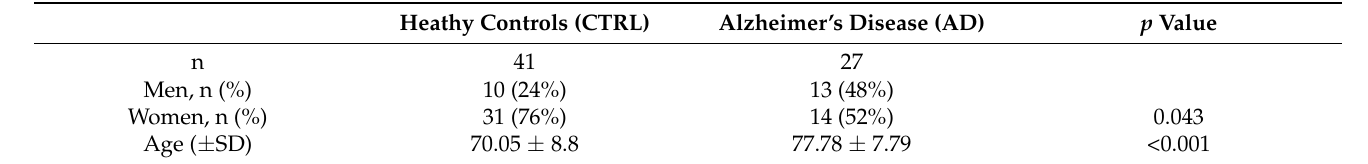
Table 1. Demographical characteristics of the study subjects.